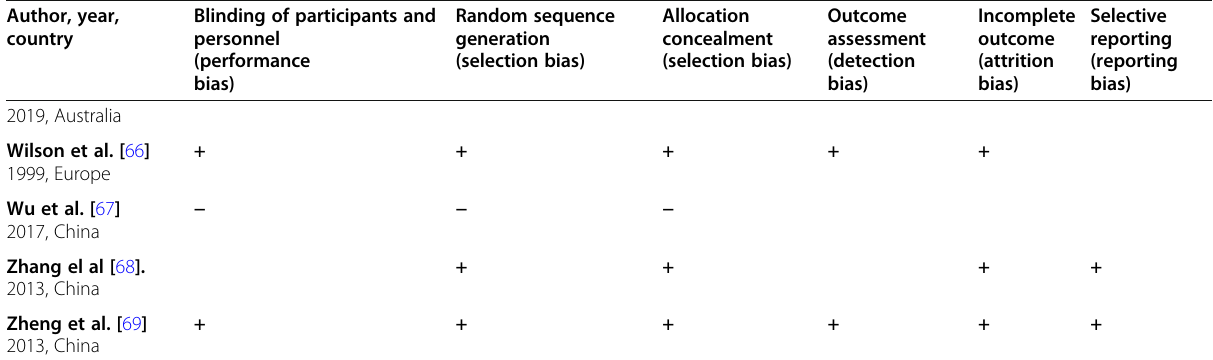
Table 2 The risk of bias assessment for each trial, according to the Cochrane domain-based evaluation